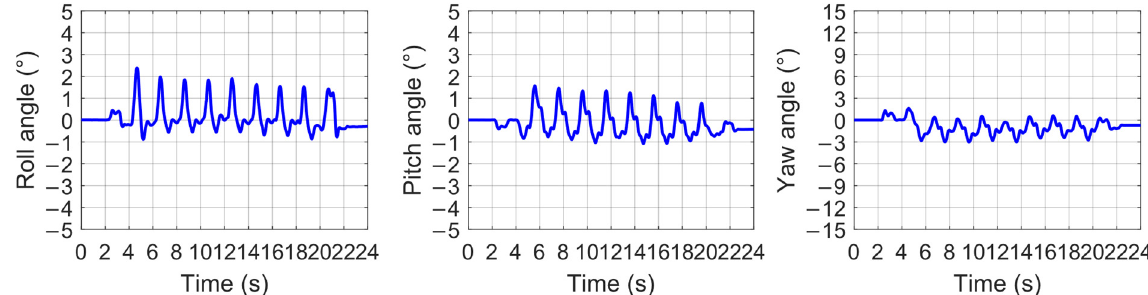
Figure 17. Attitude variations in tripod gait (without the strategy of “increasing duty factor”). Table 4. Comparison of data in two experiments.